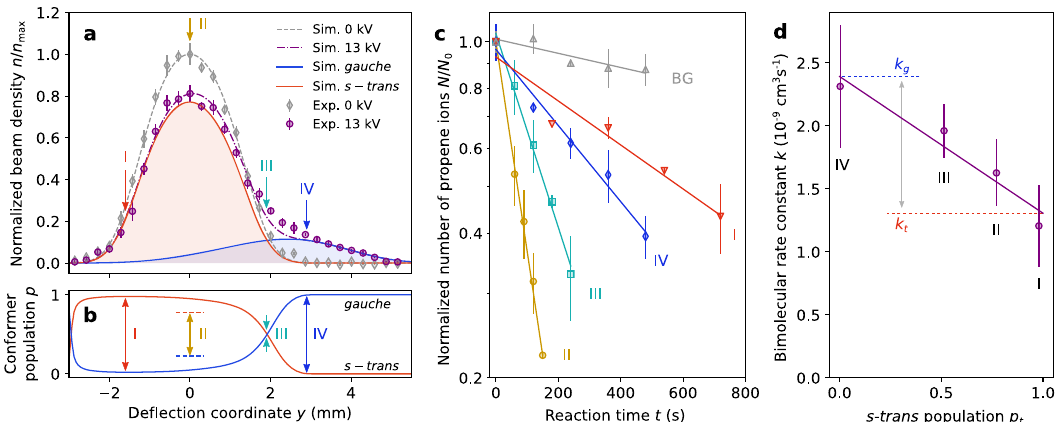
Fig. 2 Conformer-speci fi c reaction rate constants. a Measurement of the DBB beam-density pro fi le along the de fl ection coordinate for de fl ector voltages of 0 and 13 kV 36 . The experimental data (symbols) are in good agreement with Monte – Carlo trajectory simulations (lines). At a de fl ector voltage of 13 kV, the two conformers were partially separated in the molecular beam. The roman numerals I – IV indicate the de fl ection coordinates at which reaction measurements were taken. b Populations of the conformers as a function of de fl ection coordinate in the molecular beam obtained from the trajectory simulations. c Reaction kinetics measured in terms of the normalised number of propene ions in the Coulomb crystal as a function of reaction time at the de fl ection coordinates I – IV marked in a , b and a background measurement (BG) without the molecular beam hitting the crystal. The exponential decay of the number of propene ions indicates a bimolecular reaction with pseudo- fi rst-order kinetics. The data points have been normalised to the initial number of propene ions N 0 for each measurement. d Bimolecular rate constants extracted from the pseudo- fi rst-order rate constants as a function of the s-trans - conformer population. The line represents a linear fi t to the data. Error bars correspond to one standard deviation of three independent measurements.